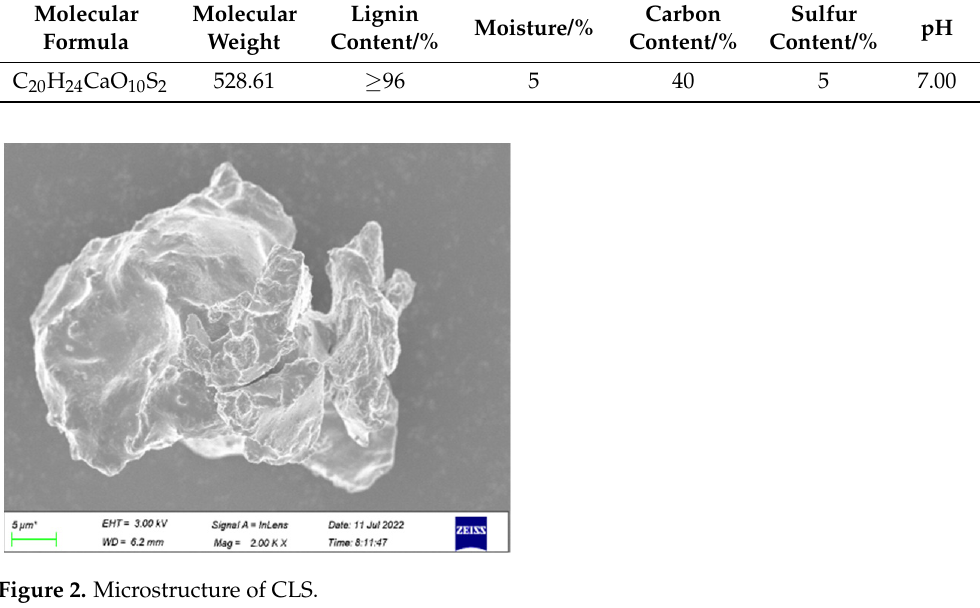
Figure 1. Calcium lignosulfonate (CLS) used in the test.